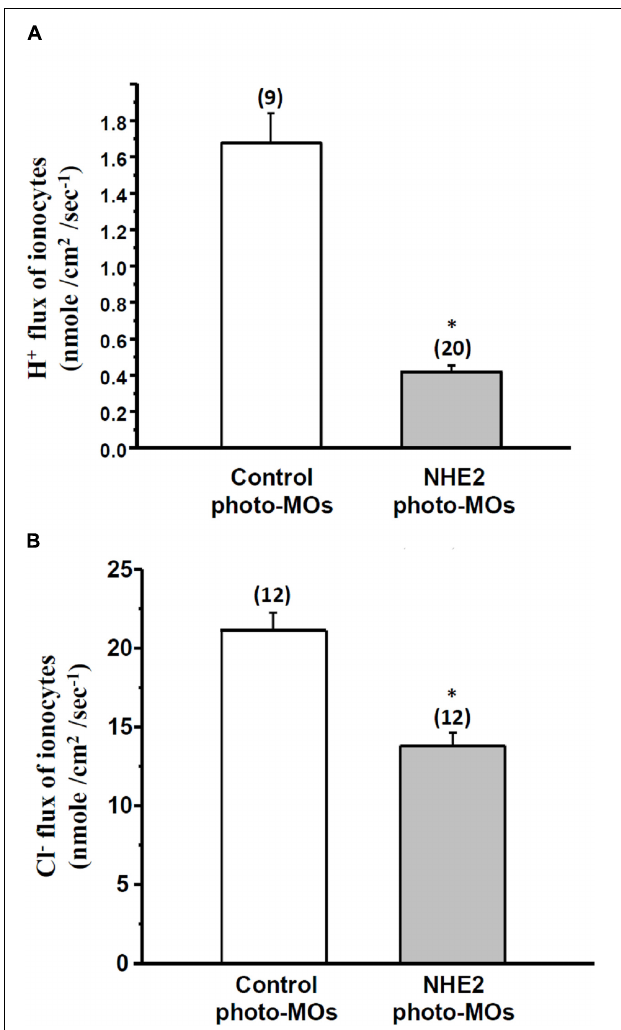
FIGURE 8 | Effects of Na + /H + exchanger 2 (NHE2)-knockdown on H + flux and Cl − flux of ionocytes in seawater (SW)-acclimated medaka embryos. Effects of control photoactivated morpholino oligonucleotides (Ctrl-photo-MOs) and NHE2 photo-MOs on H + flux (A) and Cl − flux (B) of ionocytes in medaka embryos acclimated to SW. Data are presented as the mean ± SE. The number of cells or larvae is shown in parentheses. ∗ Indicates a significant difference (unpaired two-tailed Student’s t-test , p < 0.05).